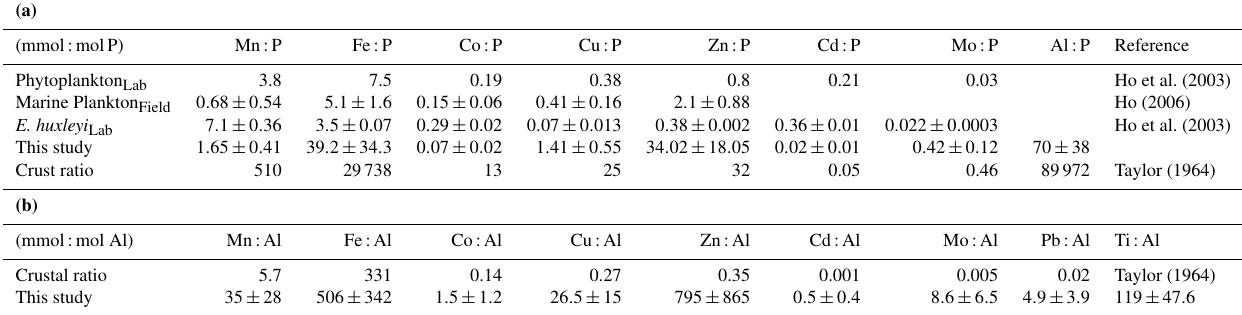
Table 2. The average metal ratios in the particles collected in this study (without oxalate wash) using the data reported in Table S2. The P-normalized ratios (mmol : molP, Fig. 2) are compared to previous estimates in marine plankton samples and phytoplankton cultures (a) . The Al-normalized ratios (mmol: mol Al) are compared to crustal ratios (b) . (a) (mmol :